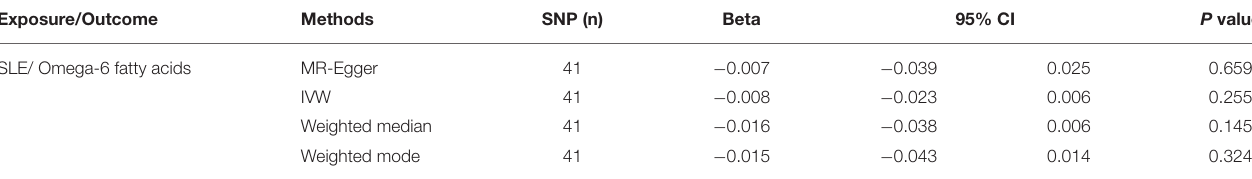
TABLE 4 | Causal effects of the risk of SLE on Omega-6.